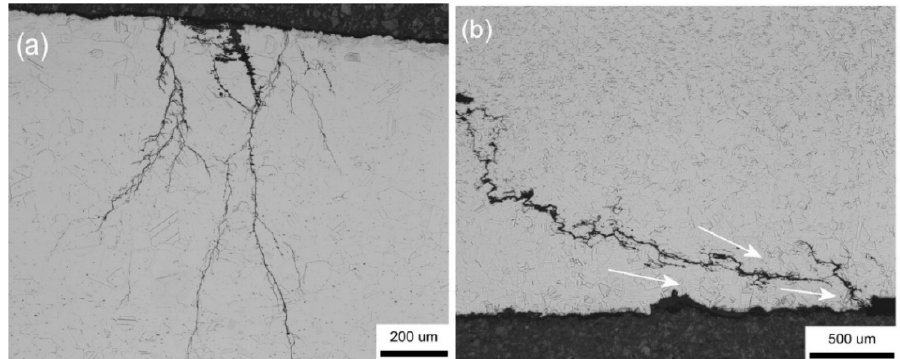
Figure 4. Transgranular type of cracks from corrosion pits on ( a ) internal surface, and ( b ) external surface [26]. Reproduced with permission from [26], Elsevier, 2014.